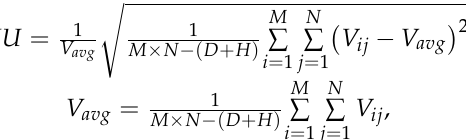
Figure 10. Evaluation images for the testing process: ( a ) greyscale baseline equivalent output of 2500, the non ‐ uniformity is 12.99%; ( b ) greyscale baseline equivalent output of 5000, the non ‐ uniformity is 8.72 %.